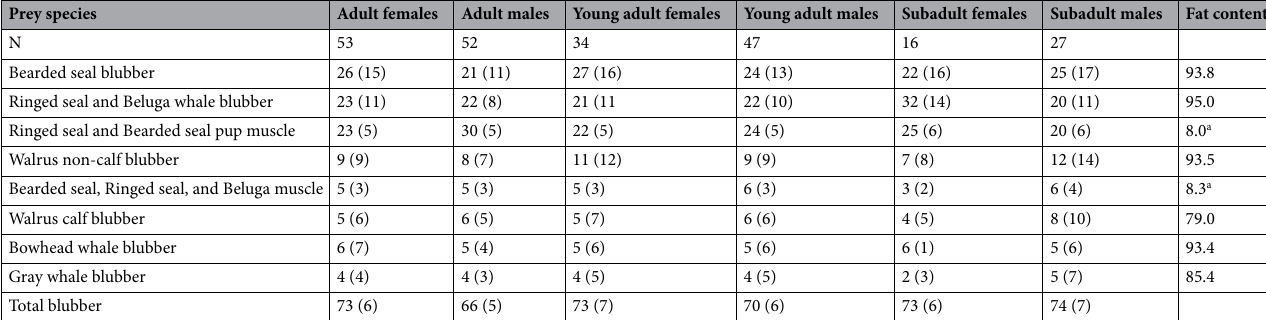
Table 1. Mean percentage (standard deviation) contributions of prey muscle and blubber to the diets of male and female polar bears in the Chukchi Sea based on a bulk isotope model using carbon and nitrogen isotopes in polar bear hair and prey muscle and blubber tissues. Dietary percentages for prey tissues that could not be differentiated in the model due to overlap in their isotopic signatures were combined. Sample sizes (n) for each sex and age class are provided in the second row. Adult bears are age > 10 years, young adults are age 5–10, and subadults are independent bears age 2–4. a Data from Yurkowski et al. 23 . For combined prey muscle we assumed seal contributed more than beluga whale and therefore used a weighted value from the range of 7.9% for ringed seals and 9.3% for beluga whale.